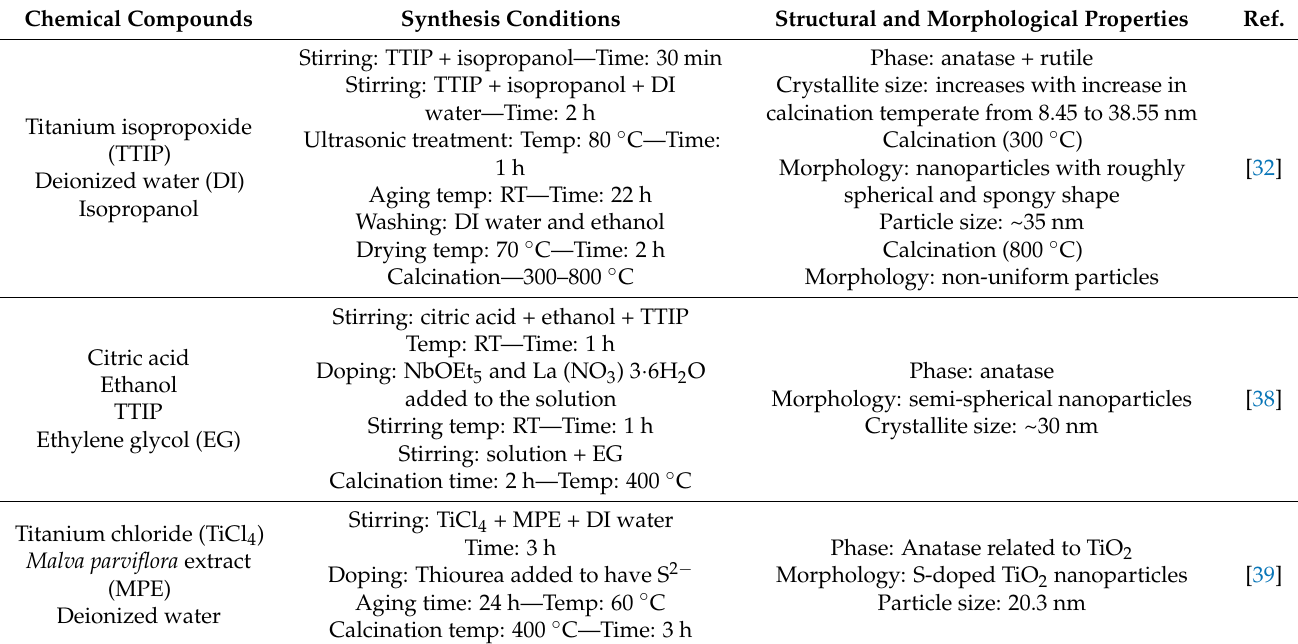
Table 1. A summary of synthesized TiO 2 nanostructures using the sol–gel method. Chemical Compounds Synthesis Conditions Structural and Morphological Properties